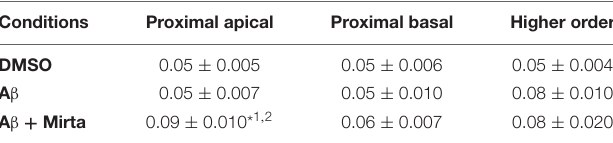
TABLE 2 | Summary of the pGOLT spot velocities ( µ